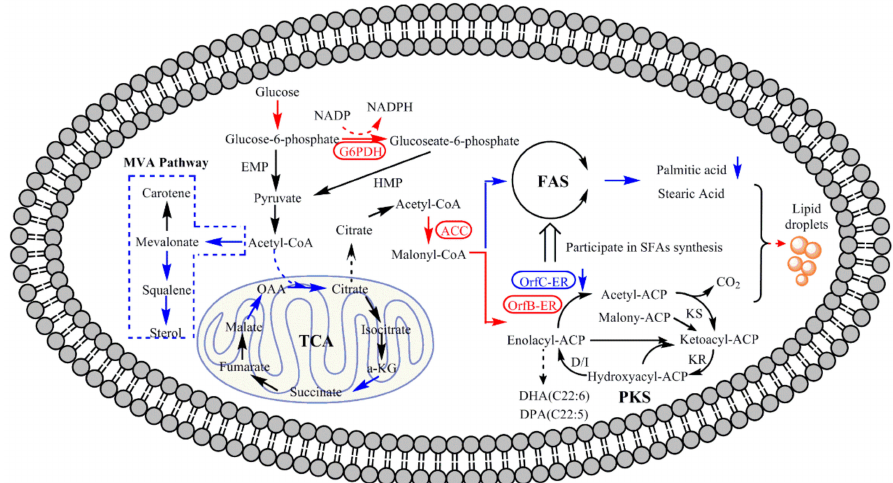
Figure 8. Functional display of OrfB-ER gene and OrfC-ER gene in fatty acid synthesis and central carbon metabolic regulation related to fatty acid biosynthesis when triclosan was added in S. limacinum . Red arrow means promoted; blue arrow means suppressed. Blue dashed box indicates that metabolic pathways are suppressed. Red oval box indicates enzyme activity increased. G6PDH: Glucose-6-phosphate dehydrogenase; ACC: Acetyl-CoA carboxylase; OrfB-ER : ER located on OrfB subunit; OrfC-ER : ER located on OrfC subunit; KS: Ketoacylsynthase; KR: β -ketoreductase; D / I: Dehydratase / Isomerase. OAA: oxaloacetic acid; a-KG: α -Ketoglutaric acid. MVA pathway: Mevalonate pathway; EMP: Glycolytic pathway. HMP: Hexose monophosphate